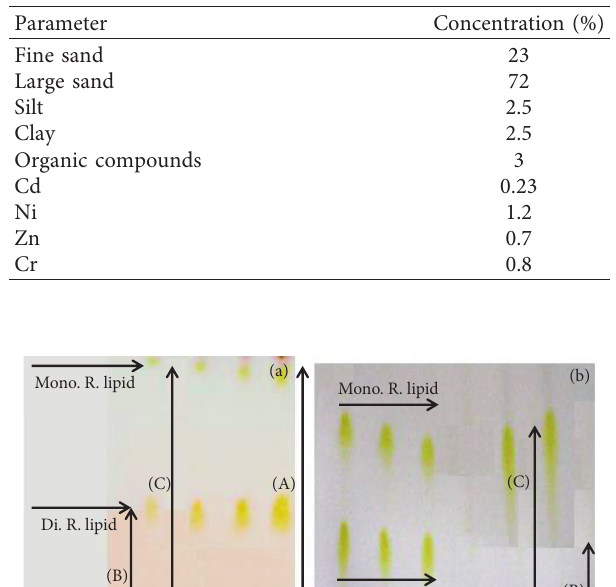
Figure 1: Luminescent bacteria growing on a nutrient agar plate in the dark Table 1: Soil characteristics and analysis.